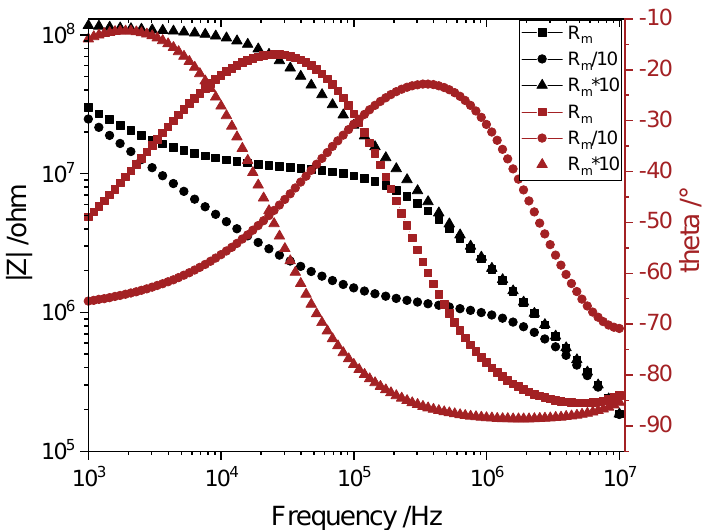
Figure 3. Bode − Plot for three different R m . Left Y − axis represents absolute Impedance versus frequency and the right Y − axis shows the phase angle theta versus